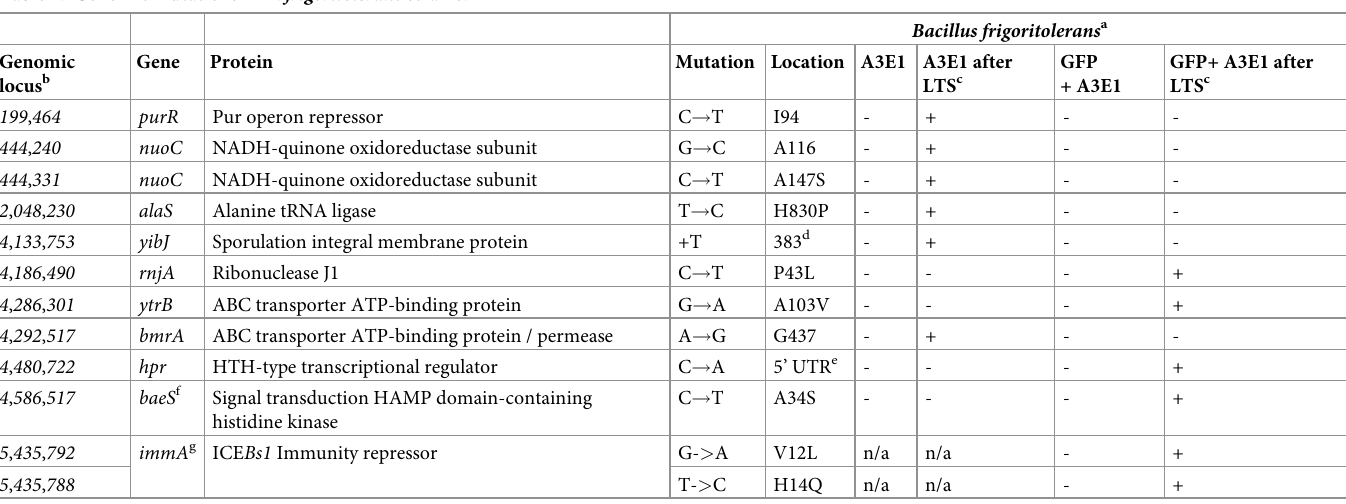
Table 2. Genomic mutations in B . frigoritolerans